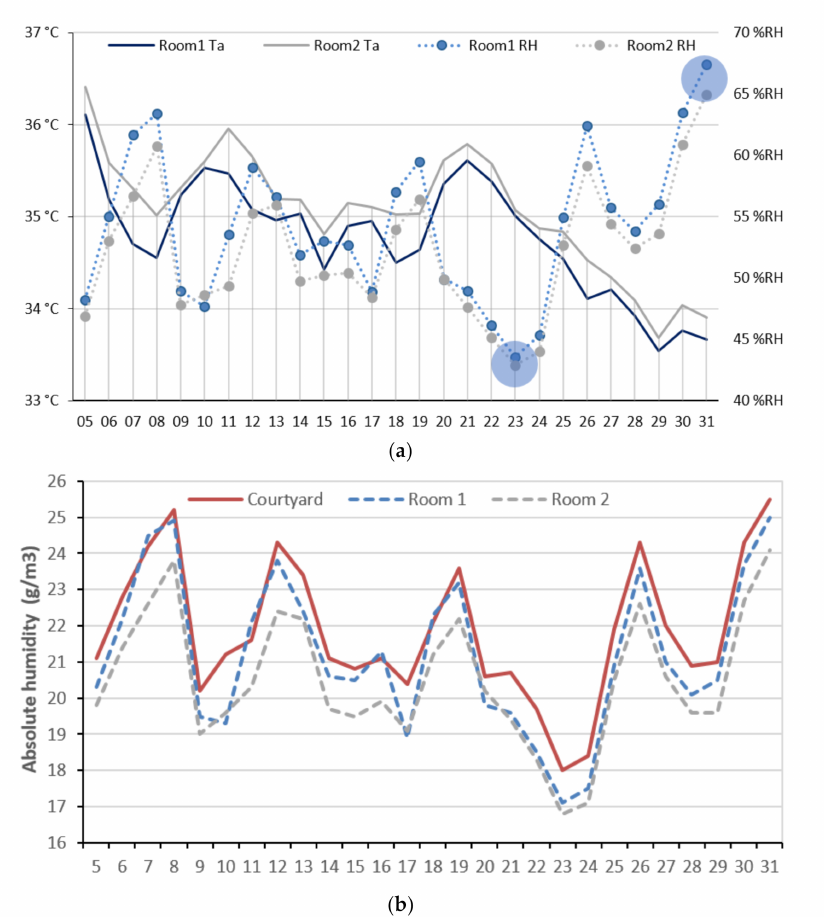
Figure 17. ( a ). Average air temperature and relative humidity for R1 and R2 from 5 to 31 August 2018; ( b ). The daily Absolute humidity for each room and courtyard from 5 to 31 August